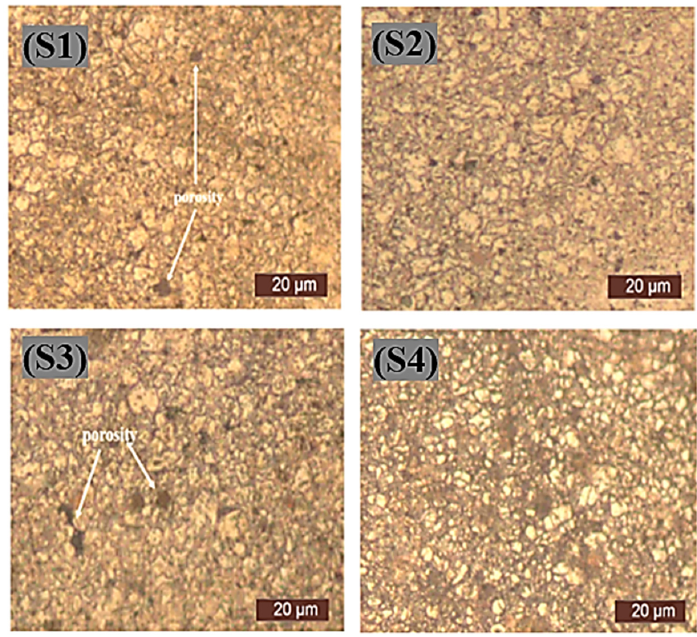
Figure 5. Microstructure of the sintered samples